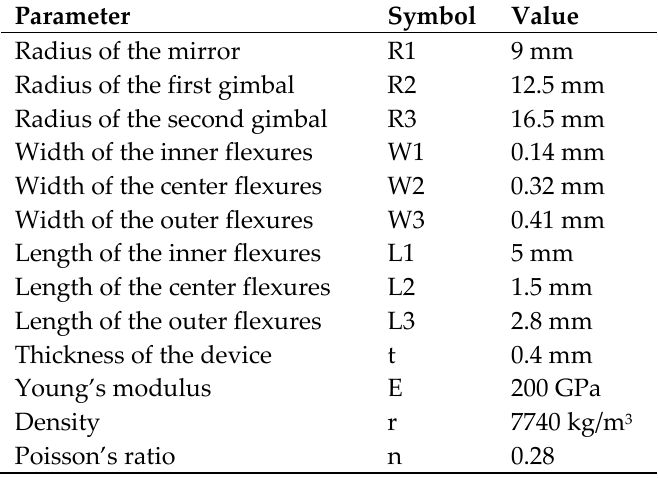
Figure 1. ( a ) Designed multi-gimbaled scanner. ( b ) The magnetic actuation principle of the scanner in terms of the interaction of the DC B-field generated by the permanent magnets and the AC flux induced by the external coil. Table 1. Dimensions and material properties of the fabricated stainless-steel